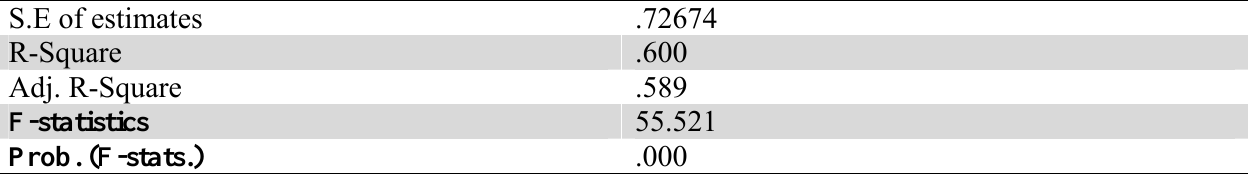
Regression analysis for over all model S.E of